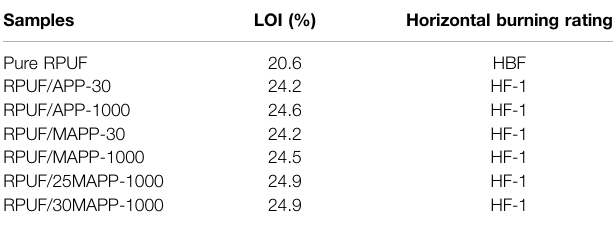
TABLE 3 | Results of LOI test and horizontal burning test for RPUF